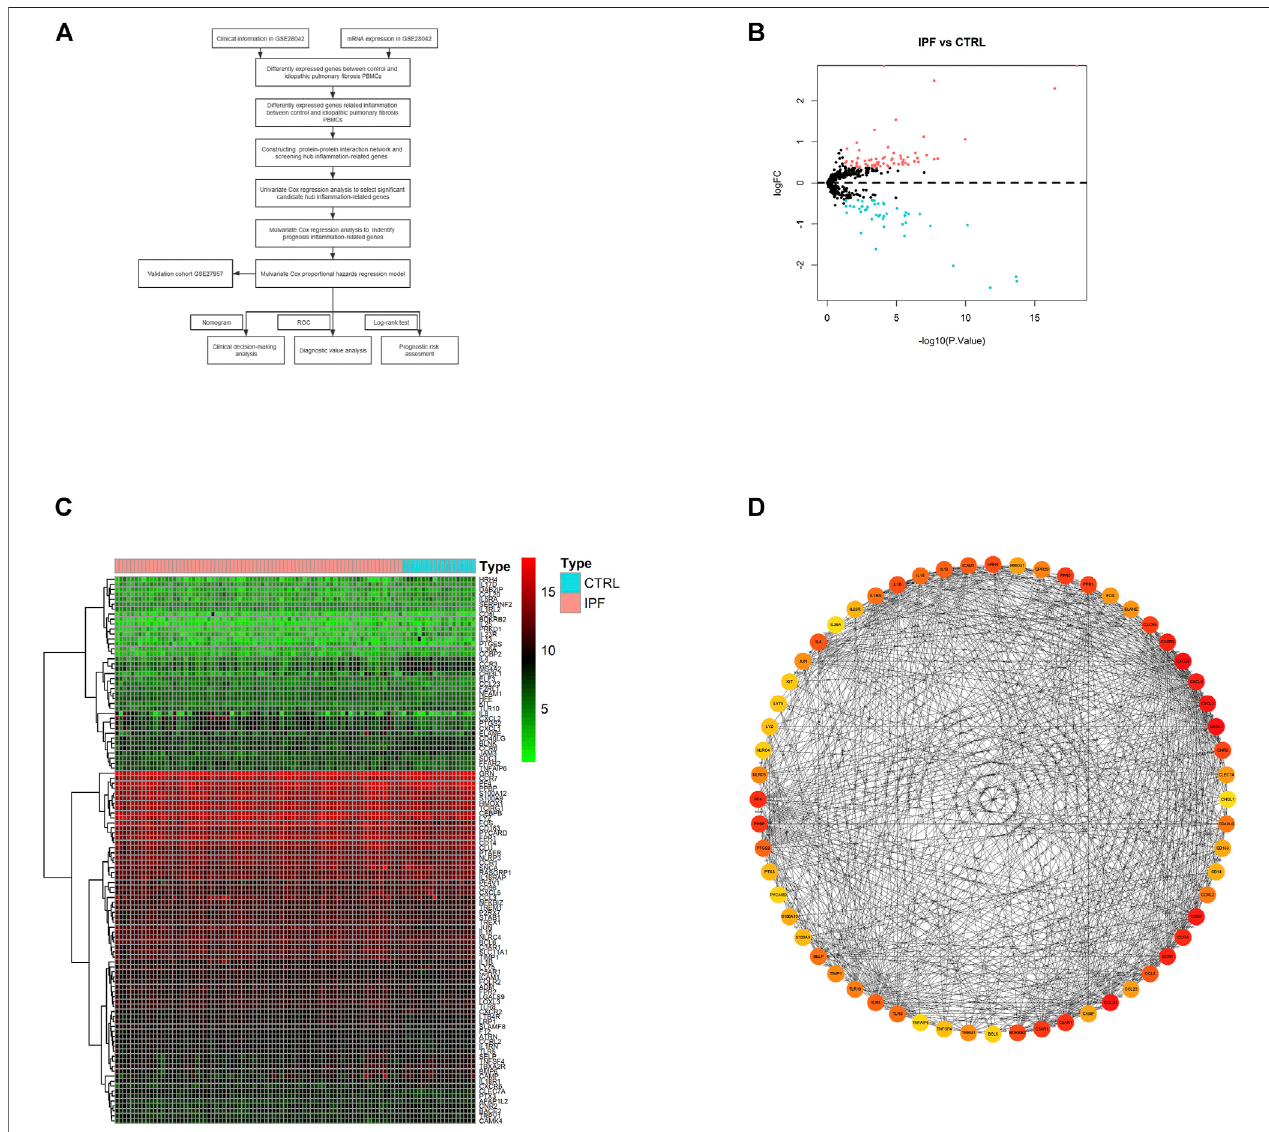
FIGURE 1 | The differentially expressed in fl ammation-related genes (IRGs) in idiopathic pulmonary fi brosis. (A) Flowchart for analyzing in fl ammation signature associated with idiopathic pulmonary fi brosis. (B) Volcano plot and (C) heatmap of differentially expressed IRGs. (D) Top 60 hub genes from protein – protein interaction (PPI)network.Bluecircles:downregulatedgeneswithafoldchangeover1.3,andredcircles:upregulatedgeneswithfoldchangeover1.3.Redcircle:highercorrelation, and orange circle: lower correlation.